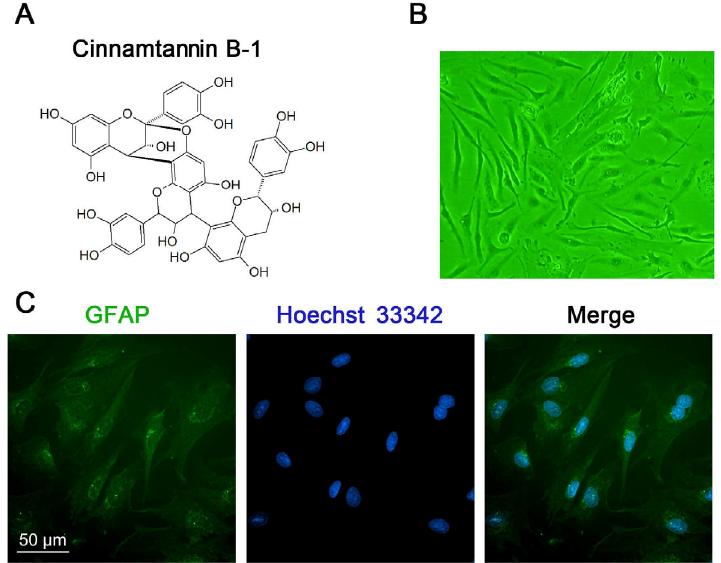
Figure 1. ( A ) The structure of cinnamtannin B-1; ( B ) Primary spinal cord astrocyte culture at 14 days; ( C ) Glial fibrillary acid protein (GFAP) staining. Over 95% of cells were stained with GFAP antibody (green fluorescence) and Hoechst 33342 (blue fluorescence). Scale bar = 50 μ m and refers to all